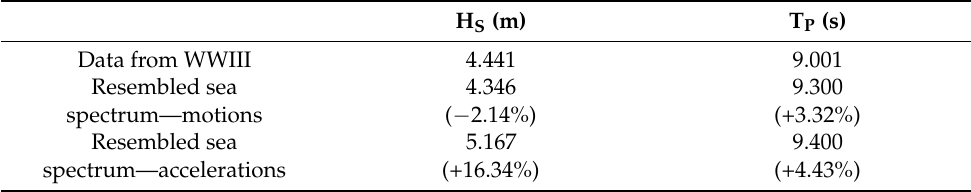
Table 5. Parameters of rebuilt spectrum for a combined sea spectrum—14 February 2020.